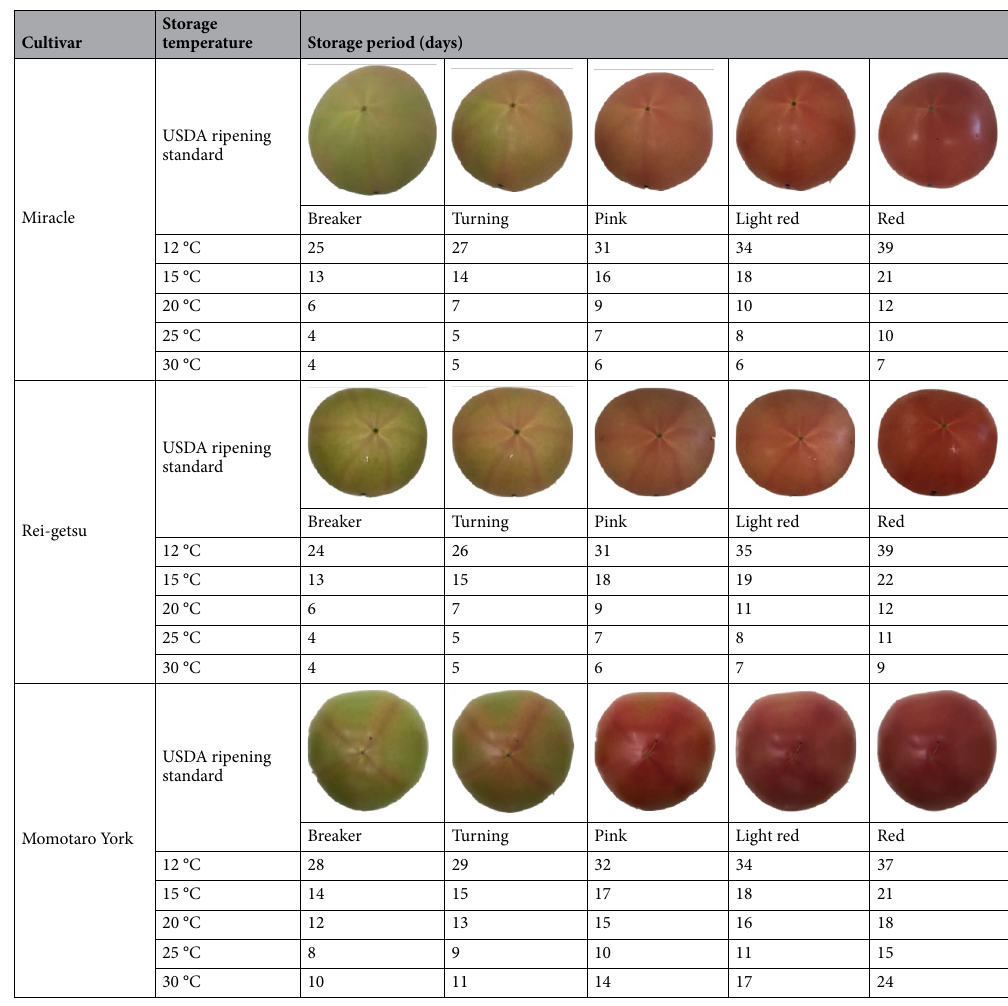
Table 2. Storage period of three tomato cultivars (Miracle, Rei-getsu, and Momotaro York) stored at 12, 15, 20, 25, and 30 °C to reach the standard ripening stages (breaker, turning, pink, light red, and red) established by United States Department of Agriculture (USDA). Tomato pictures shown in the table were stored at 15 °C from the respective cultivar.